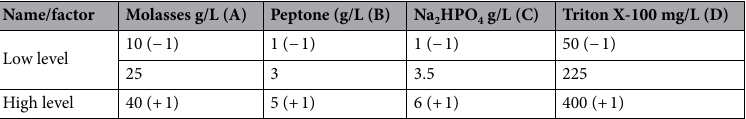
Table 1. Experimental range and variable levels for second